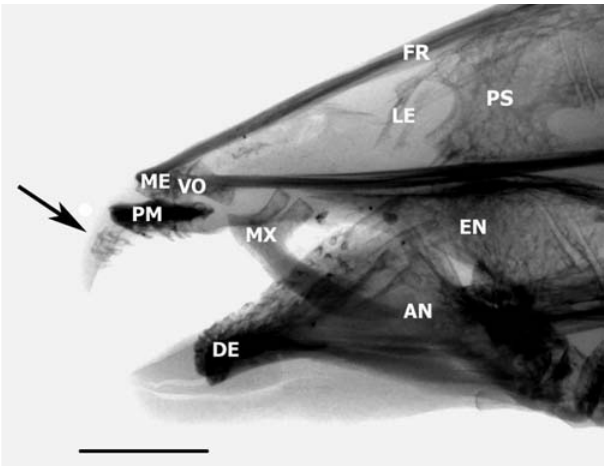
Fig. 2. Radiograph (inverted) showing skeletal structures at the anterior portion of head of the holotype of Tembeassu marauna (MZUSP 48510). Arrow at left indicates the patch of extra teeth inside the mouth (roof of the oral cavity), loosely attached to soft tissue in front of the premaxillary bones (PM). Additional abbreviations are as follows: AN = anguloarticular; DE = dentary; EN = endopterygoid; FR = frontal; LE = lateral ethmoid; ME = mesethmoid; MX = maxilla; PS = pterosphe- noid; VO = vomer (ventral ethmoid). Scale bar ~ 5 mm.